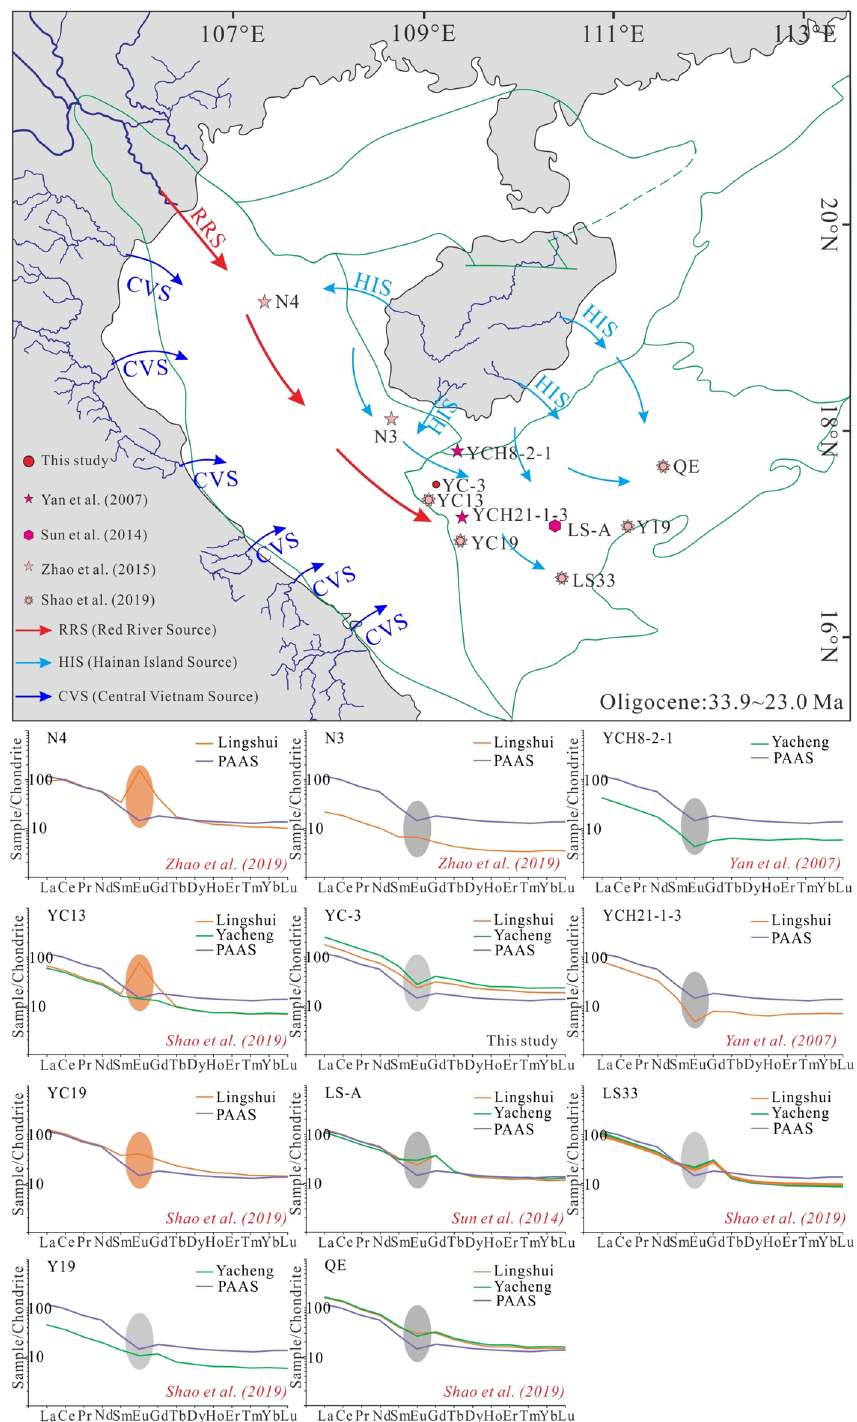
Figure 10. Schematic source-to-sink evolution model and chondrite 50 normalized REE patterns of Oligocene samples from the Yinggehai and Qiongdongnan basins. Eu-anomaly values are highlighted on each plot with gray (negative) or orange (positive) shades. The square part of the Yinggehai and Qiongdongnan basins in the upper map to display the provenance distribution. Intervals in each REE pattern plot indicate the Formation analyzed. PAAS—Post-Archean Australian